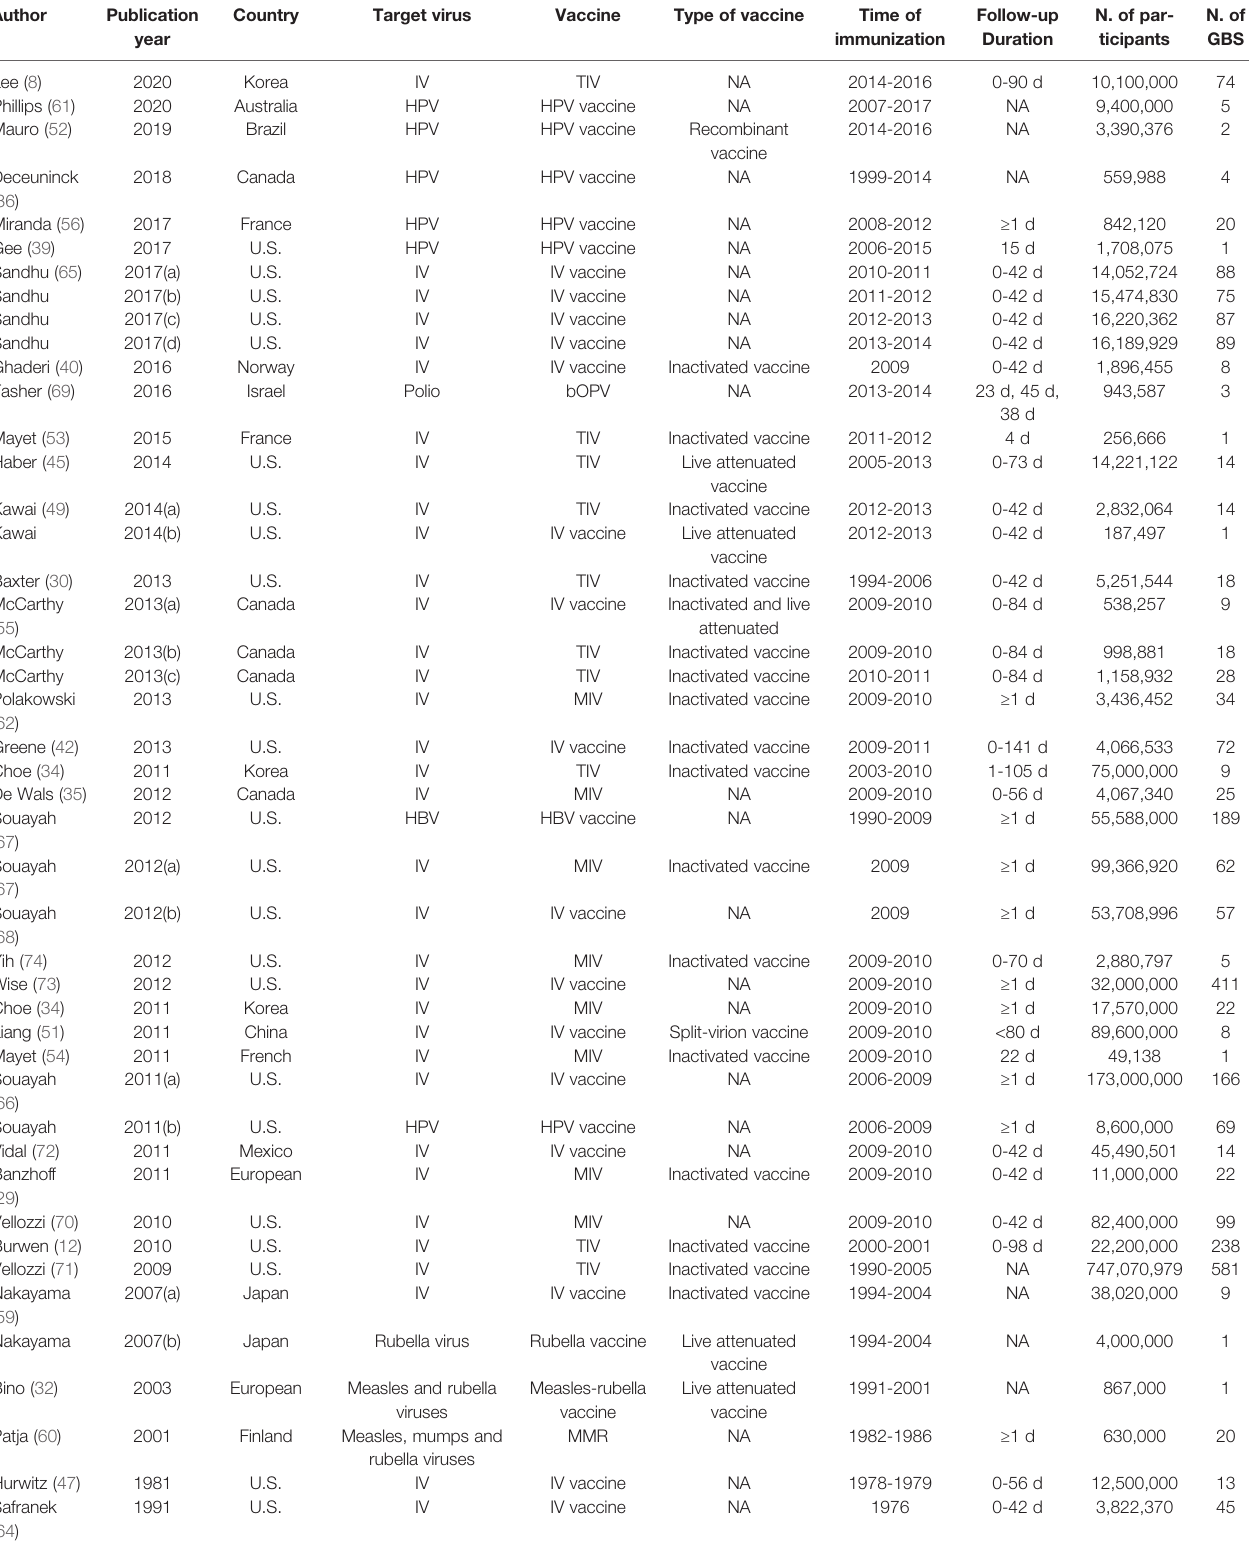
TABLE 1 | Characteristics of included